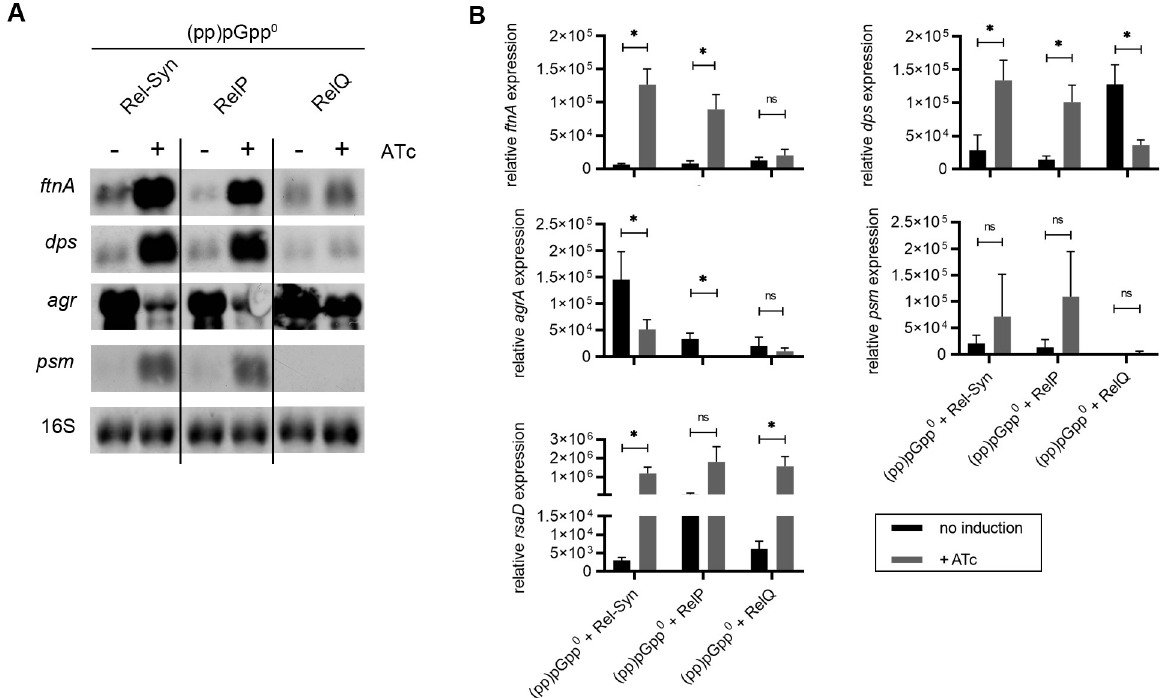
Fig 4. Gene expression following induction of rel-Syn , relQ or relP in USA300 strain background. A. Strain USA300 and derivatives were grown to OD 600 = 0.3 and treated for 30 min without or with 0.1 μ g/ml ATc (mutant strains with inducible rel-Syn , relP or relQ ). For Northern blot analysis, RNA was hybridized with digoxigenin-labelled probes specific for ftnA , dps , psm α or agrA . The 16S rRNA detected in ethidium bromide-stained gels is indicated as a loading control in the bottom lane. B . Quantification of mRNA by qRT-PCR based on three biological replicates. Statistical significance was determined by two-tailed Student´s T-test, � p � 0.05, �� p � 0.01, ��� p � 0.001 and ���� p � 0.0001.